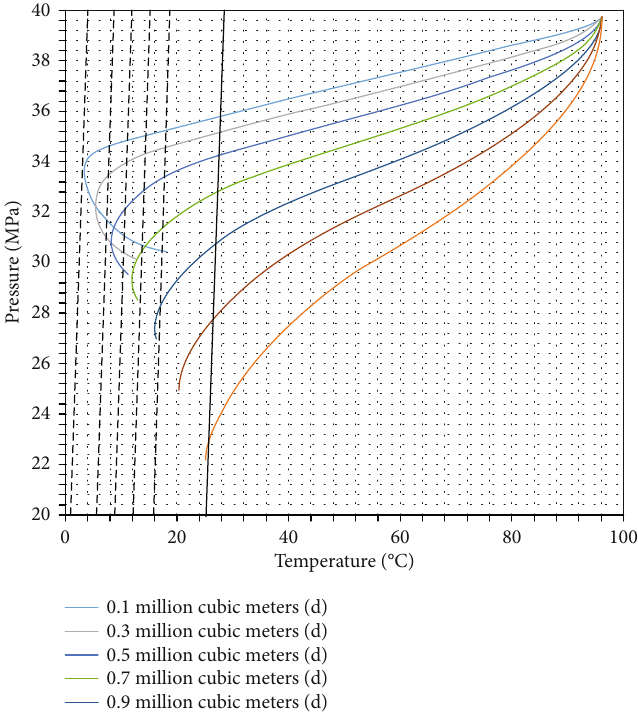
Figure 9: Judgment chart of gas hydrate formation in well (ethylene glycol).